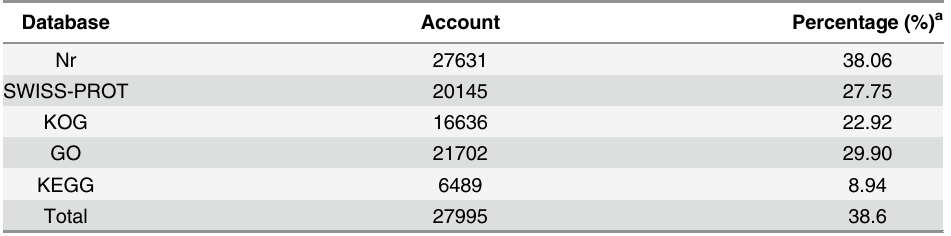
Table 2. Statistics of annotations for assembled unigenes in W . ugandensis